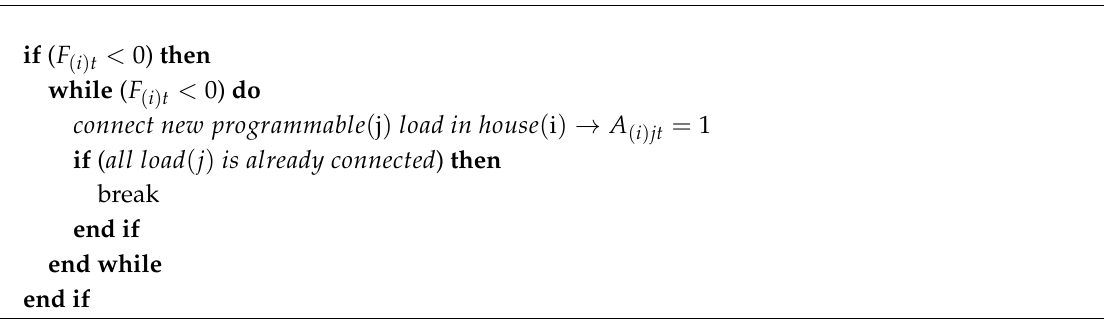
Algorithm 1 Minimize function F (